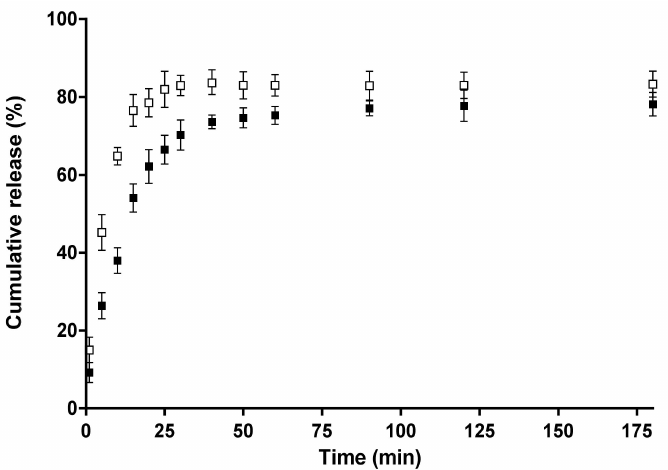
Figure 5. Release profiles of 5-Cl8Q from fibrous membranes of CA / 5-Cl8Q ( (cid:4) ) and CA / PEG / 5-Cl8Q ( (cid:3) ). The results are presented as average values from three separate measurements with the respective standard deviation; acetate bu ff er / lactic acid (96 / 4 v / v ), pH 3, 37 ◦ C, and an ionic strength of